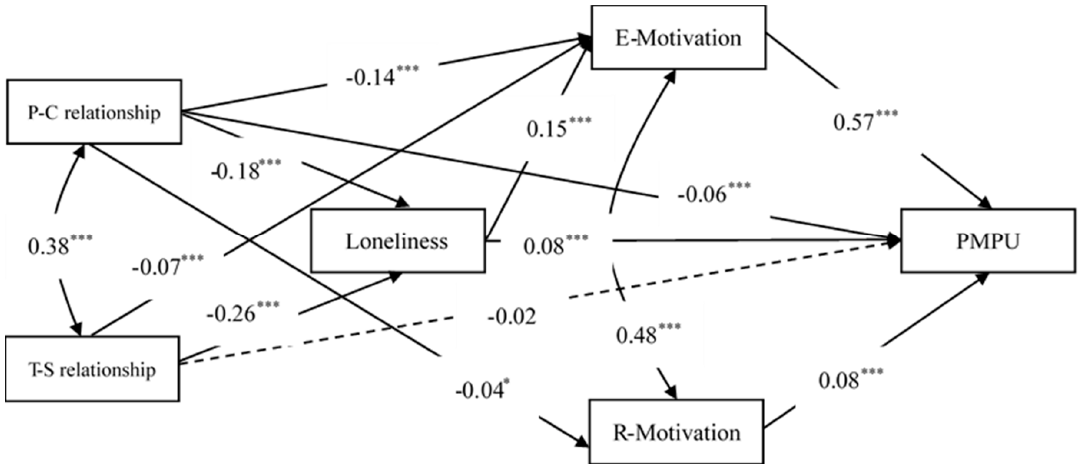
Figure 1. The multiple indirect effects model of parent–child/teacher–student relationship on problematic mobile phone use. P–C relationship = Parent–child relationship, T–S relationship = Teacher–student relationship, E-Motivation = Escape motivation, R-Motivation = Relationship motivation, PMPU = Problematic mobile phone use. Dashed line represents a non-significant coefficient, single arrows represent predicting paths from one variable to another and bi-arrows represent correlations between dimensions of one variable. Predicting paths without a mediator indicate the direct effect(s), whereas with a mediator(s) the indirect effect(s). * p < 0.05, *** p < 0.001.